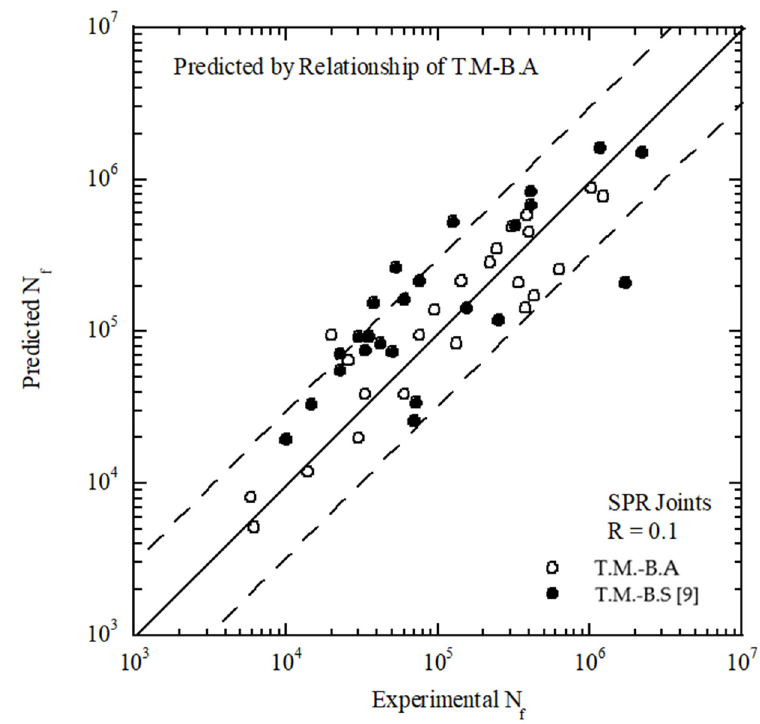
Figure 17. Fatigue lifetime predictions of the T.M-B.A and T.M-B.S [9] SPR joints under three loading conditions adopting the relationship of T.M-B.A.